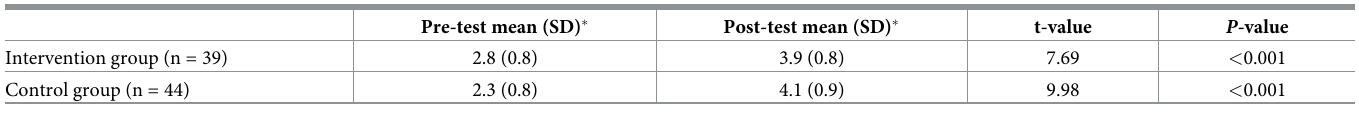
Table 1. Pre-test and post-test self-confidence in DTR examinations.